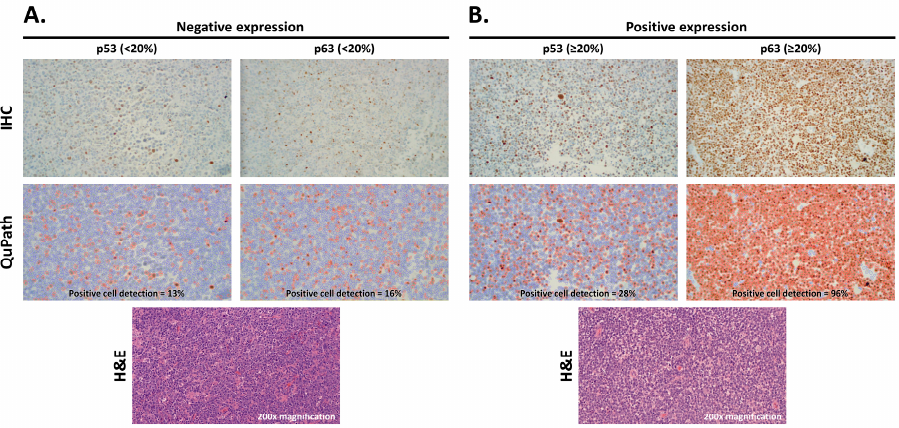
Figure 1. Representative H&E images, IHC of p53 and p63 staining, and positive cell detection using QuPath images showing negative expression ( A ) and positive expression ( B ). Negative expression (<20%) is depicted as blue nuclei and positive expression ( ≥ 20%) as red nuclei in QuPath (200× mag ‐ nification).